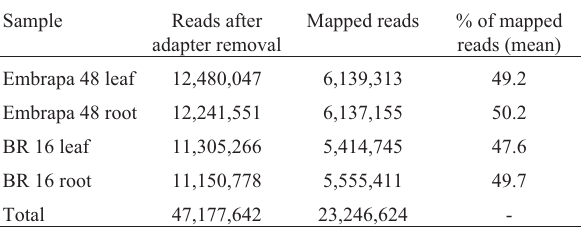
Table 1 - Differential gene expression in leaves and roots from the cultivars BR 16 and Embrapa 48 under conditions of moderate and severe water deficit stress.